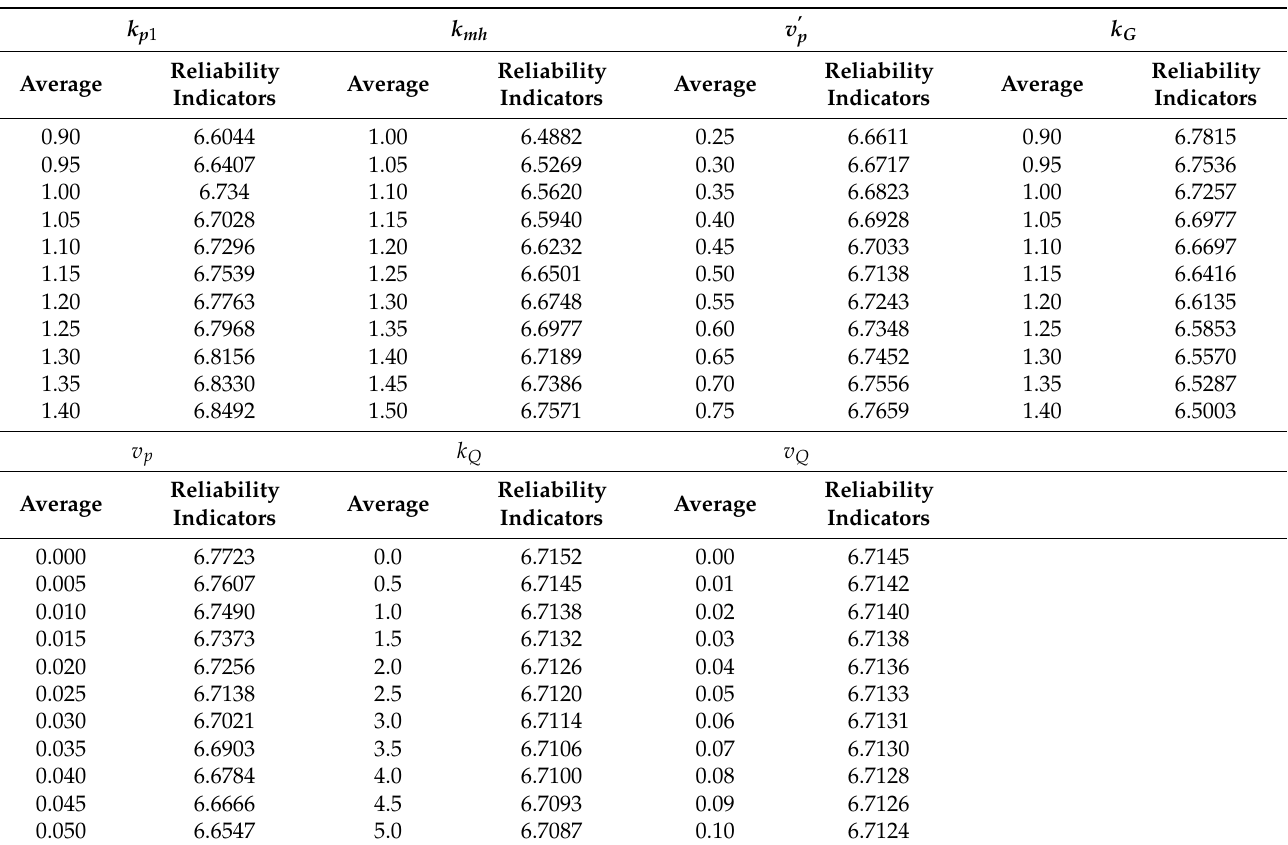
Figure 5. Effect of coefficient of variation of each parameter on strength reliability index under combination I. Table 5. Effect of coefficient of average value of each parameter on strength reliability index under combination I.